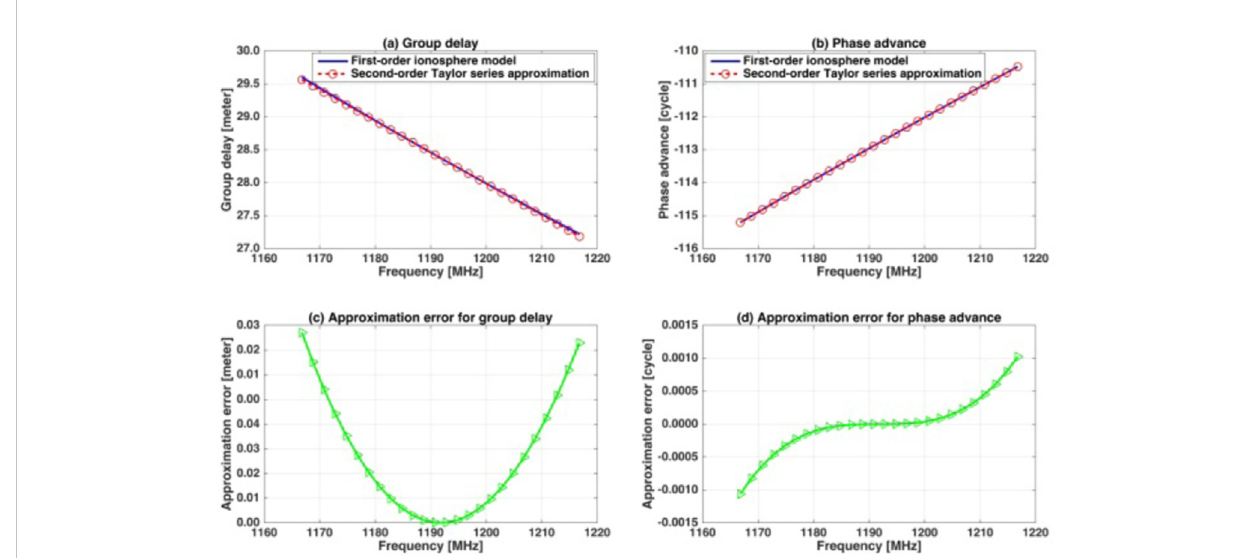
FIGURE 1 Group delay and phase advance of E5 AltBOC(15, 10) signals calculated from the conventional fi rst-second ionosphere model and second-order Taylor series approximation